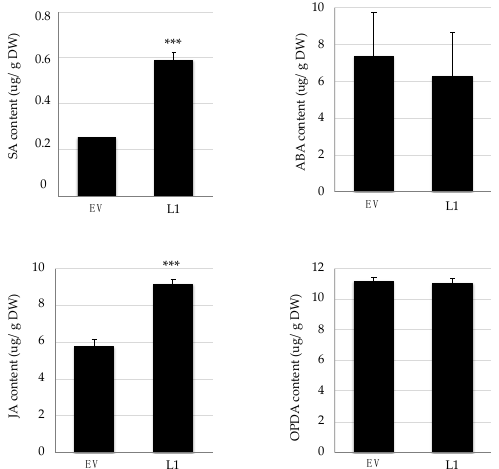
Figure 5. Basal hormone levels in transgenic Vitis vinifera plants expressing VriATL156 . The con- centration (expressed in µg/g dry weight) of salicylic acid (SA), jasmonic acid (JA), abscisic acid (ABA) and 12-oxophytodienoic acid (12-OPDA) was measured in the leaves of non-infected control (empty vector) plants and L1 transgenic line expressing VriATL156 under the control of the CaMV 35S promoter. Data are means of three biological replicates ± SE. Statistically significant differences are indicated as: *** = p ≤ 0.01 calculated with Student’s t